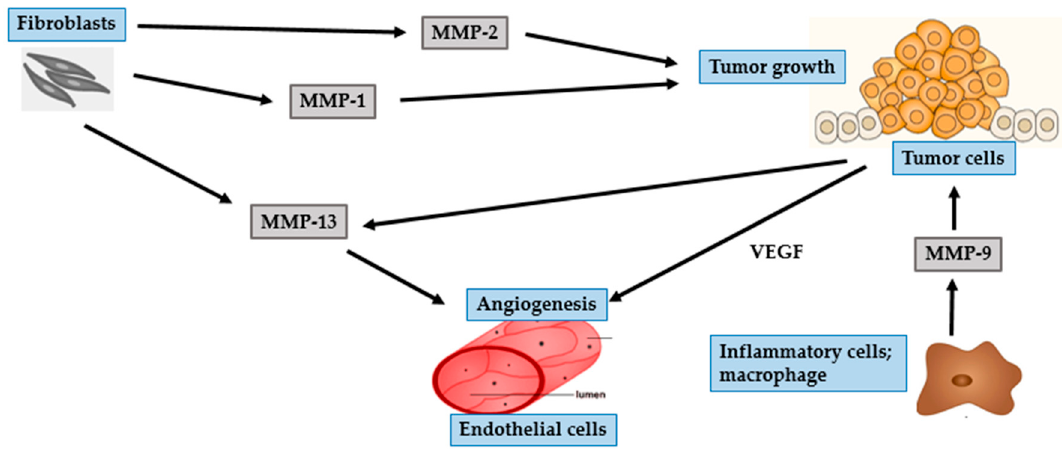
Figure 2. Role of MMPs in BCC and tumor growth. MMP-1 and MMP-2 secreted by fibroblasts facilitate tumor growth. MMP-13 secreted by fibroblasts and tumor cells promote tumor angiogenesis. MMP-9 secreted by inflammatory cells activates BCC cells to secrete VEGF, which in turn promotes angiogenesis.